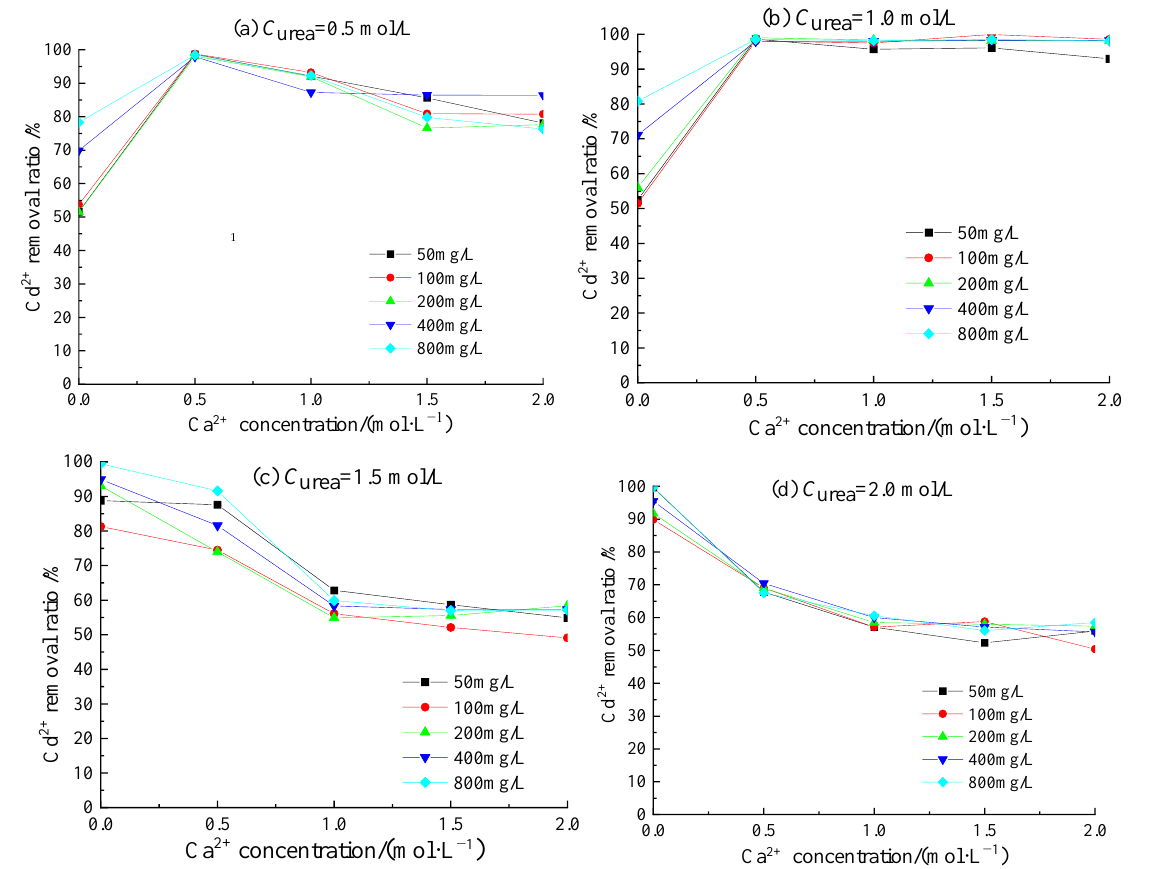
Figure 4. Removal ratio of Cd 2+ with different urea concentrations (( a ) C urea = 0.5 mol/L; ( b ) C urea = 1.0 mol/L; ( c ) C urea = 1.5 mol/L; ( d ) C urea = 2.0 mol/L).